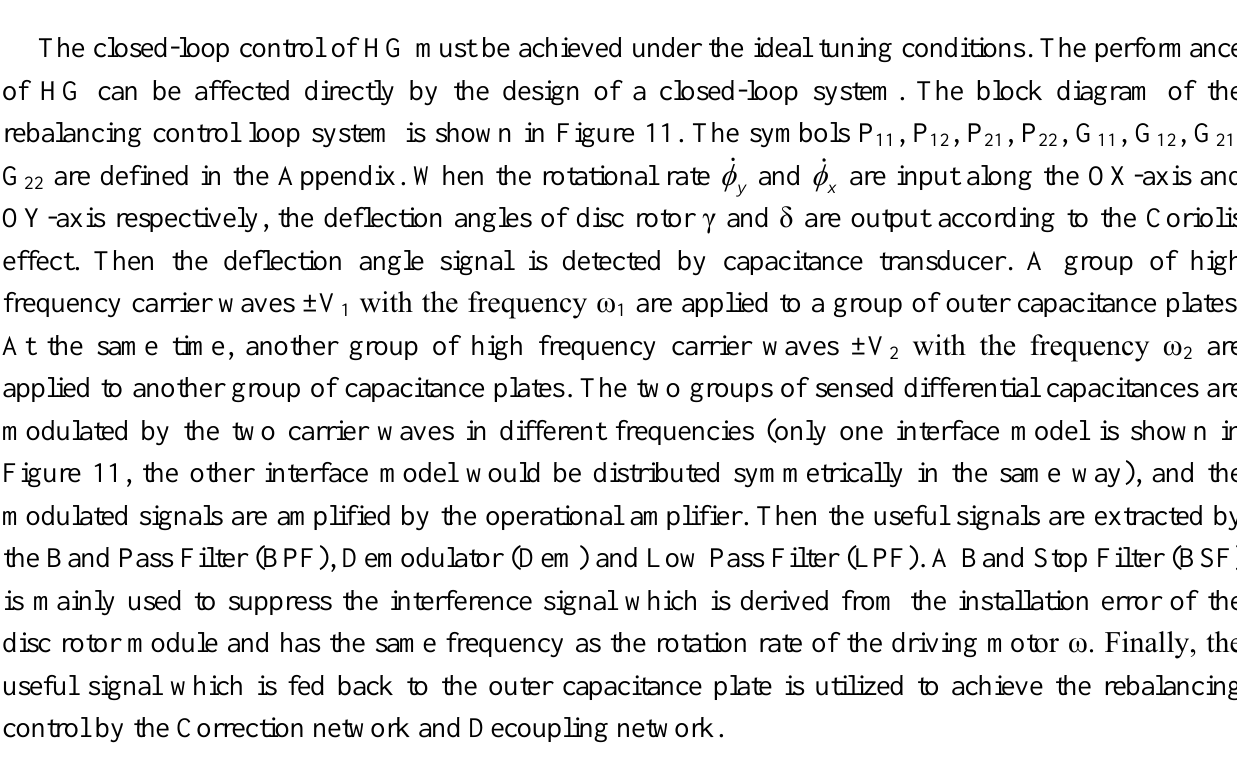
Figure 11. Block diagram of the rebalancing control